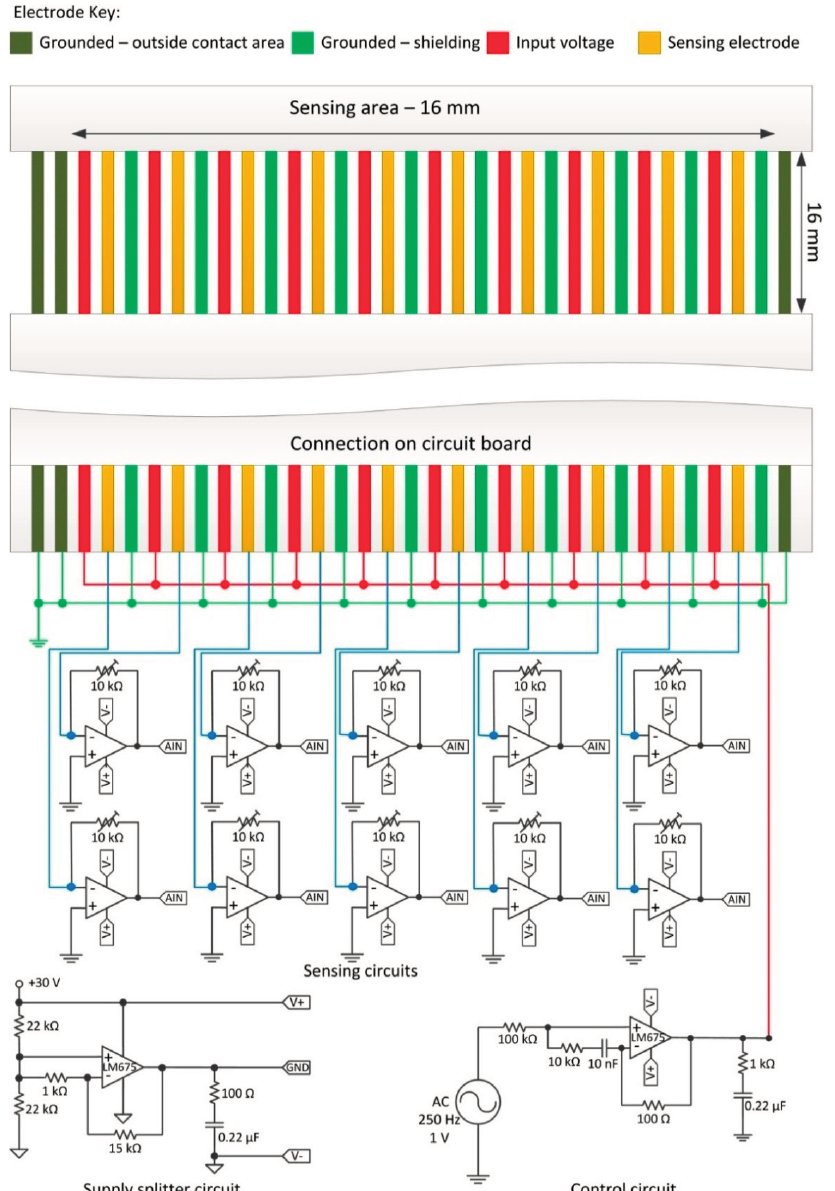
Figure 3. The monitoring circuitry for the impedance sensor